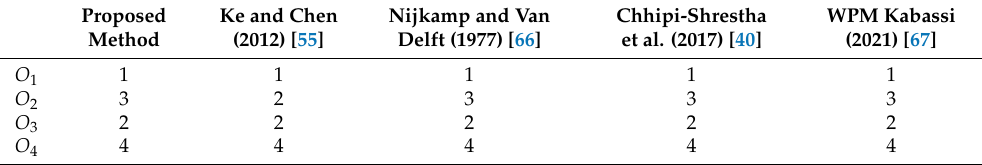
Table 23. The final result.